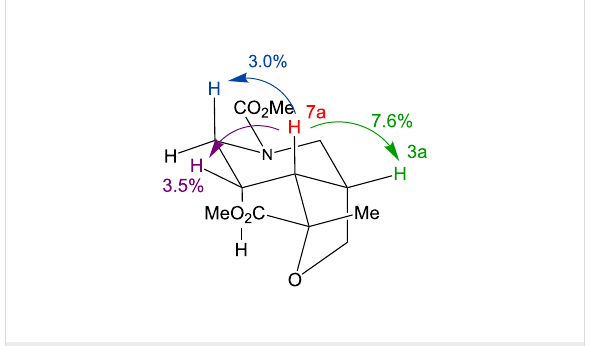
Yields are greatest if the enolate is first stabilised as a silyl enol ether, presumably because acylation of the pyridine ring to give the electrophilic acylpyridinium species is cleaner. The bicyclic dihydropyridine products are unstable towards re-aromatisation, but can be isolated in moderate to excellent yield if they are hydrogenated in situ, especially when oxygen is excluded prior to and during the